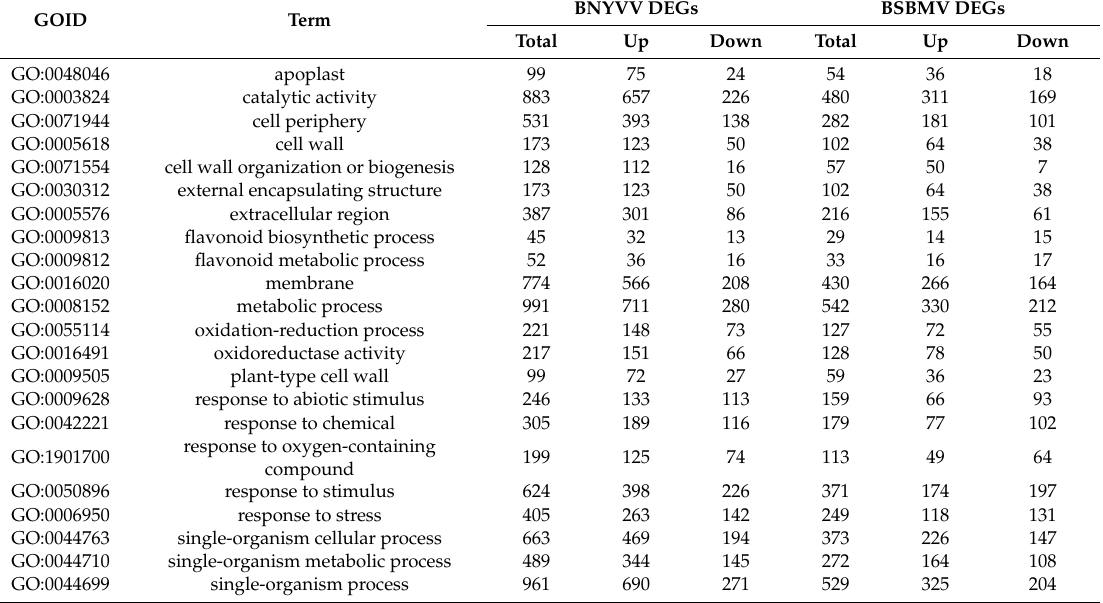
Figure 2. Analysis of di ff erentially expressed genes (DEGs) in BNYVV- and BSBMV-infected plants from a susceptible genotype. Volcano plots display log2 fold change plotted against the p -values ( − log10) of all genes expressed in BNYVV ( a ) and BSBMV ( b ) infected plants. The Venn diagram shows the comparison of up- and downregulated DEGs between BNYVV and BSBMV ( c ). The log2 fold change of DEGs from BNYVV and BSBMV were plotted against each other ( d ). Table 2. Top 20 of significantly enriched gene ontology (GO) categories of di ff erentially expressed genes (DEGs) from BNYVV- and BSBMV-infected